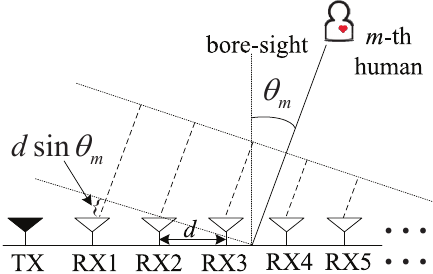
Figure 1. Transmit and receive antennas with unit linear array.